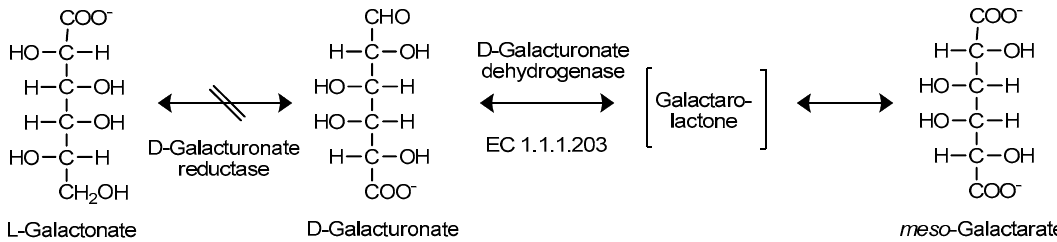
Figure 9. Engineering of the ᴅ -galacturonic acid pathway in fungi. Deletion of the gene encoding ᴅ -galacturonate reductase resulted in strains unable to utilize ᴅ -galacturonic acid as a carbon source. The expression of the bacterial udh gene, encoding an nicotinamide adenine dinucleotide (NAD)-dependent UDH ( ᴅ -galacturonic acid dehydrogenase), resulted in fungal strains that were able to oxidize ᴅ -galacturonic acid to meso -galactaric acid. UDH forms a galactaro-lactone that spontaneously hydrolyzes [100].